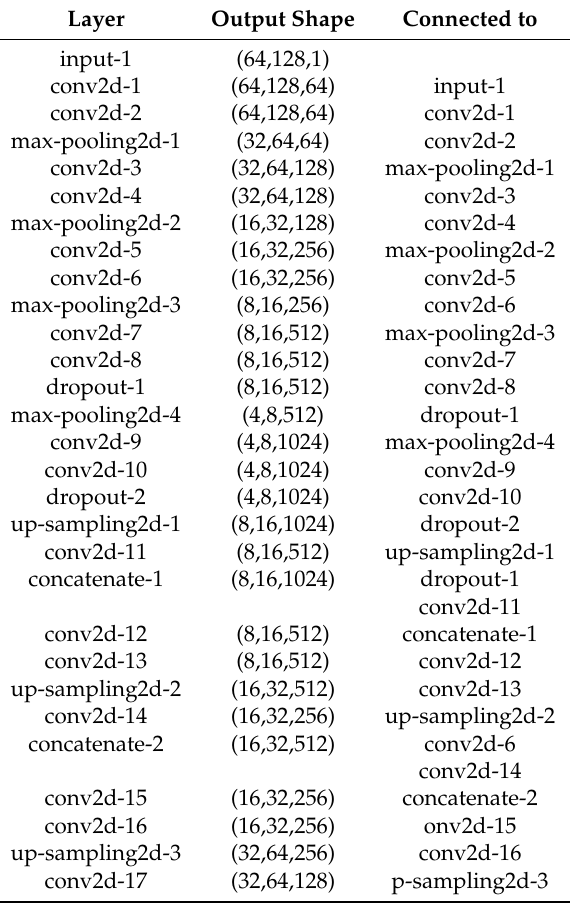
Figure 5. Schematic of the network structure. The network structure consists of 23 conventional layers. The input layer involves the patches of the PSTM migration images, and the output layer involves the corresponding high-resolution versions of the image (obtained using the QPSTM). The network is not entirely symmetric. In the encoding and decoding phases, the layers’ size is transformed from 64 × 128 × 1 to 4 × 8 × 1024 and from 4 × 8 × 1024 to 64 × 128 × 1, respectively. The activation function of the encoder and decoder layers is the ReLU. The activation function of the layer before the output is tanh because the co-domain of the ReLU is [ 0, + ∞ ] , and the actual expected result is [ − 1, + 1 ] . The arrow line between the encoder and decoder layers is the skip connection, which maintains the spatial resolution and positional information and ensures that the feature maps from the up-sampling are more elaborate. Moreover, the introduction of the skip connection makes the network less sensitive to a new data set and ensures that the network has a stronger generalization ability. Table 1. Parameters of each